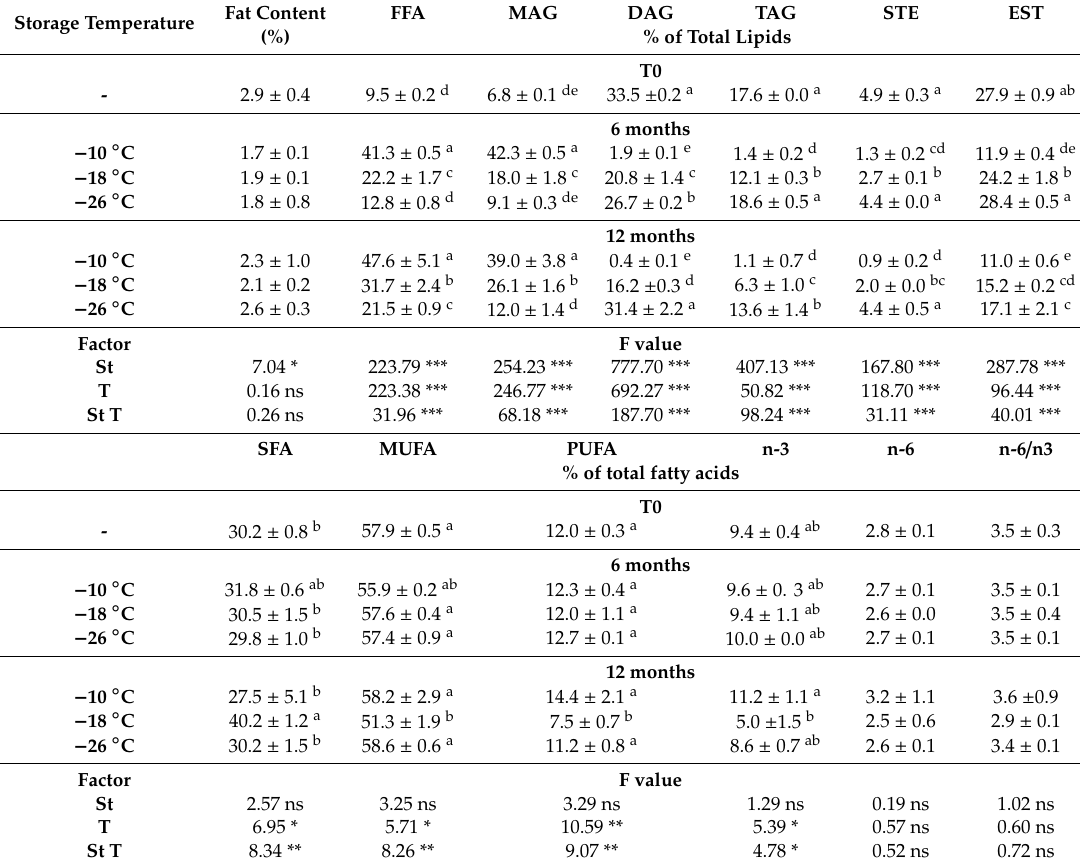
Table 3. Composition of lipid classes (expressed as % of total lipids) and the fatty acid classes (expressed as % of total fatty acids) of the mechanically separated mantis flesh, after 0, 6 and 12 months storage at di ff erent